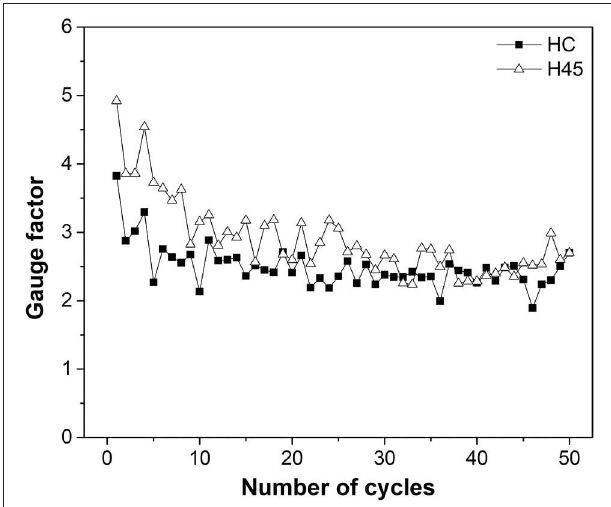
FIGURE 11 | Gauge factor of the 6 wt.% CNT 3D-printed nanocomposite samples along a number of cycle strain of HC and H45.